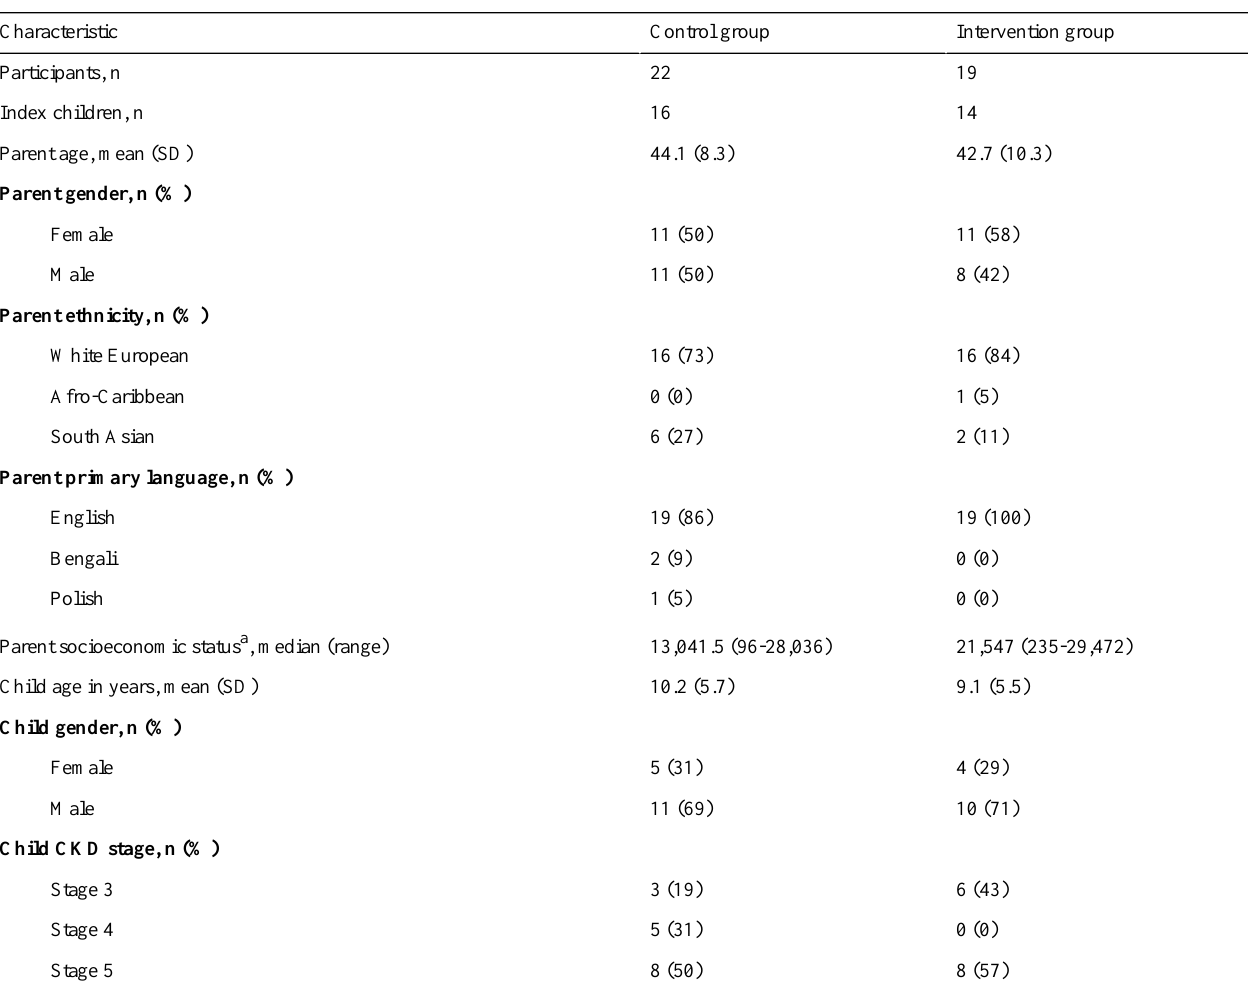
Table 2. Parent and child characteristics by randomization group at baseline for those completing trial.